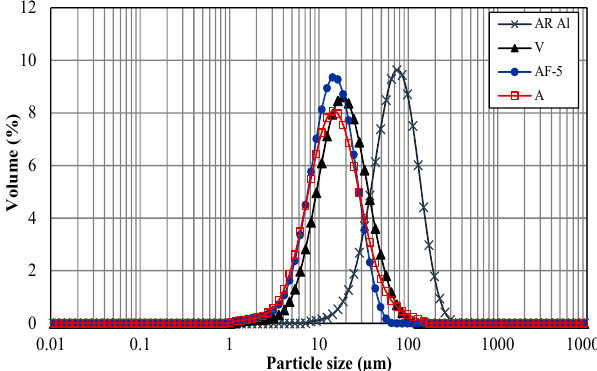
Figure 1. Granulometric distribution of milled powders. A: confined ammonia; AF ‐ 5: vacuum followed by 5 min ammonia gas flow; AR Al: as ‐ received aluminum powder; V: vacuum.